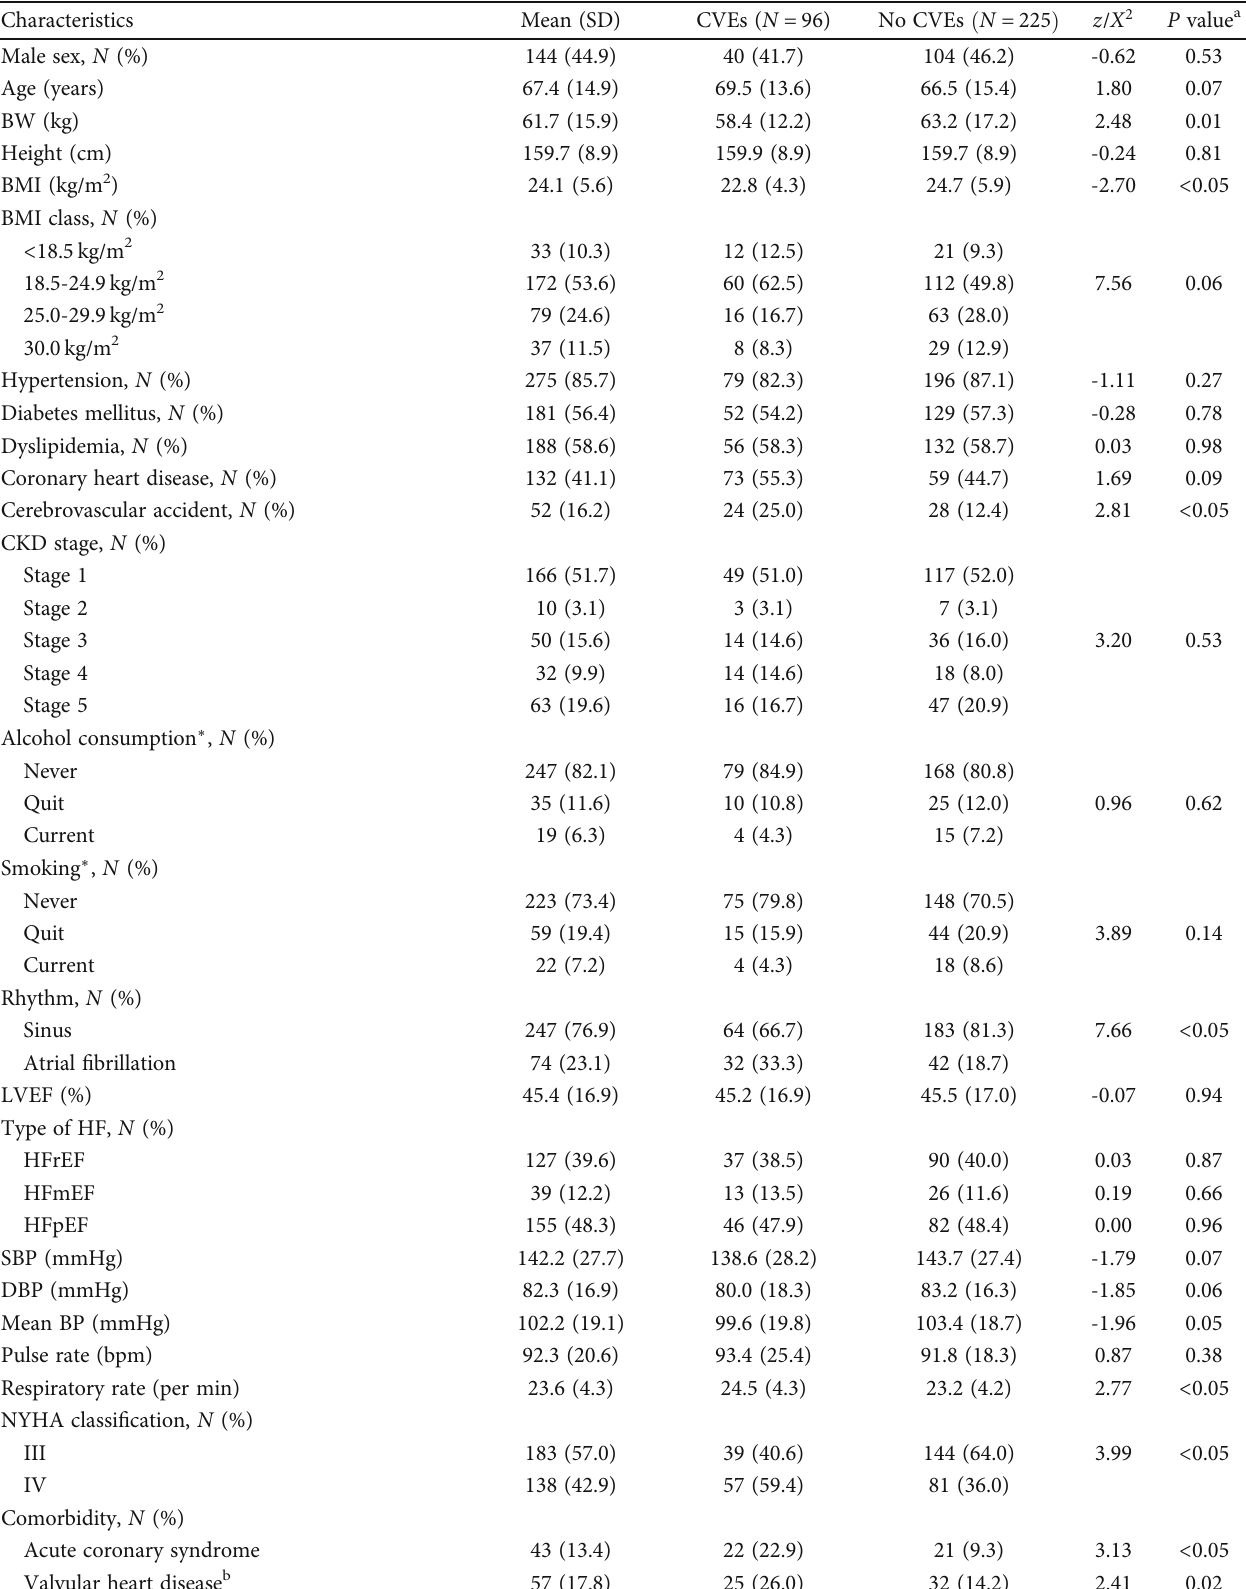
Table 1: Baseline characteristics of patients with heart failure, strati fi ed by cardiovascular events.